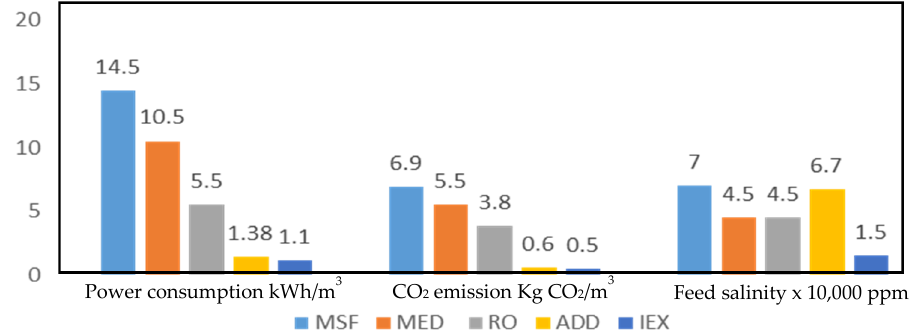
Figure 5. Comparison among desalination technologies with main operational parameters [60].